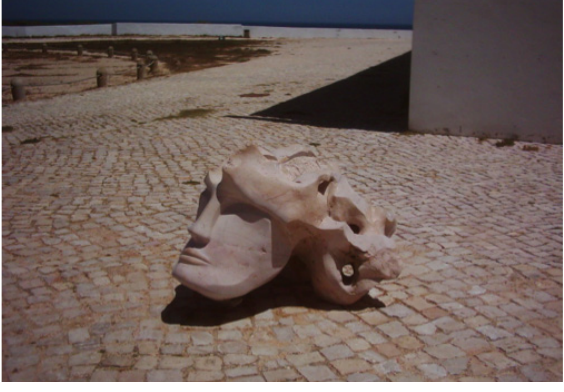
FIGURE 21 | Author Unknown, Untitled, Sagres Fortress,